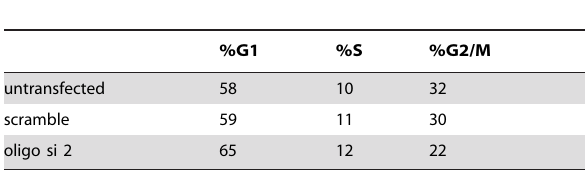
Table 2. Percentage of cells in each cell cycle phase by flow cytometry for knockdown of NET4/TMEM53 and controls in U2OS